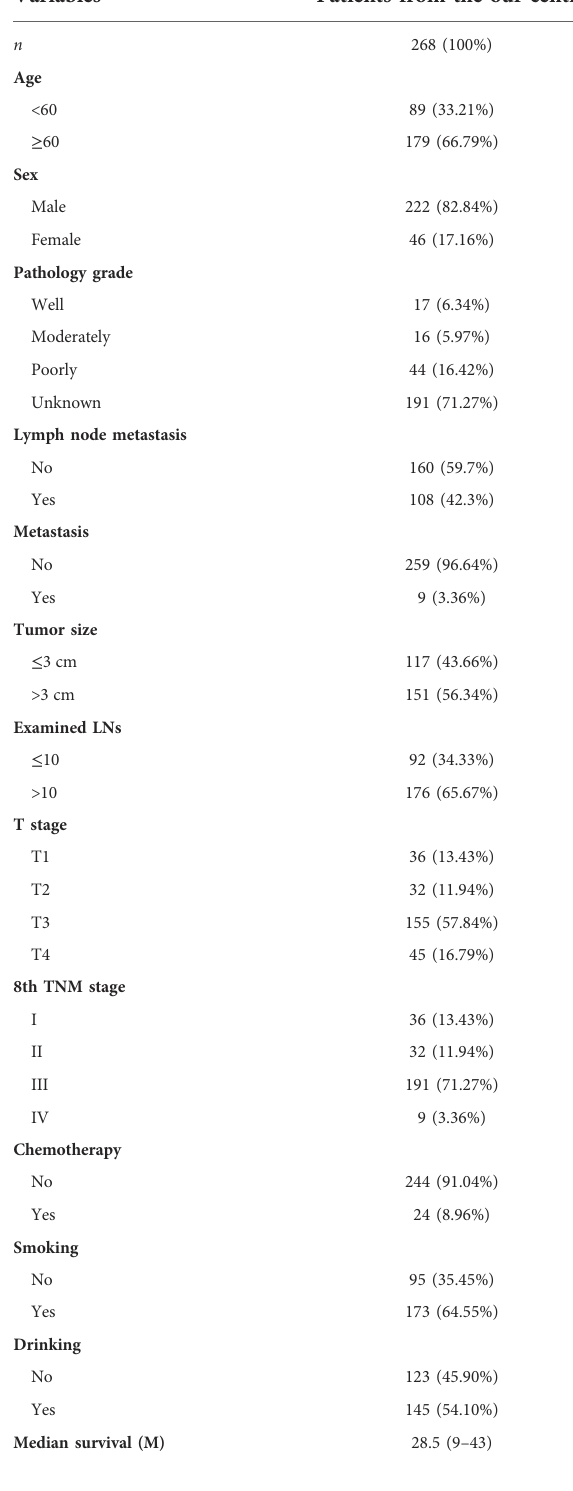
TABLE 2 Patients ’ demographics, clinical characteristics at diagnosis in our